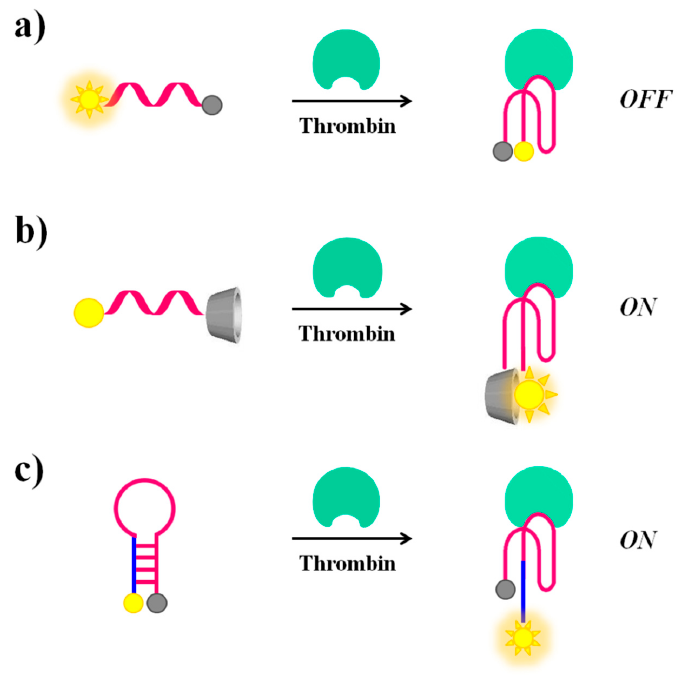
Figure 7. Schematic representation of molecular beacons undergoing conformational changes upon thrombin recognition: switch from a random coil to a G4 structure, causing a “turn-off” ( a ) or a “turn-on” ( b ) of the fluorescence signal and from a hairpin to a G4 structure ( c ), with a “turn on” of the fluorescence emission.